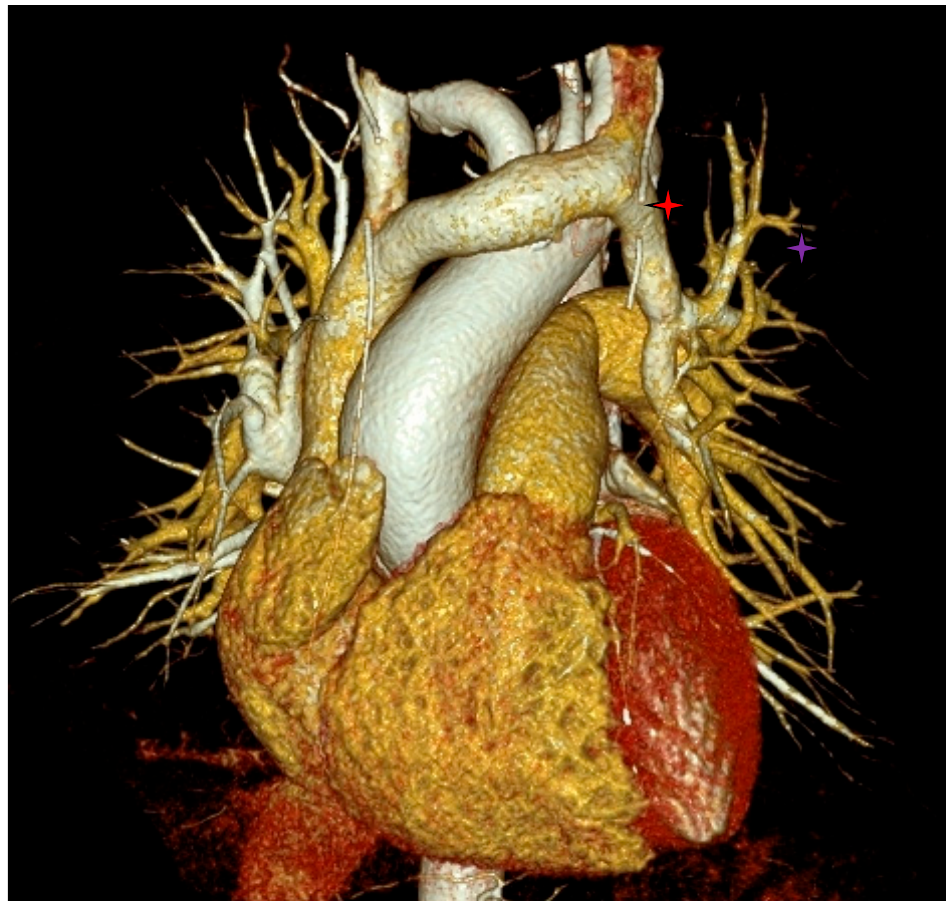
Figure 8. Left superior pulmonary vein draining into left brachiocephalic vein.